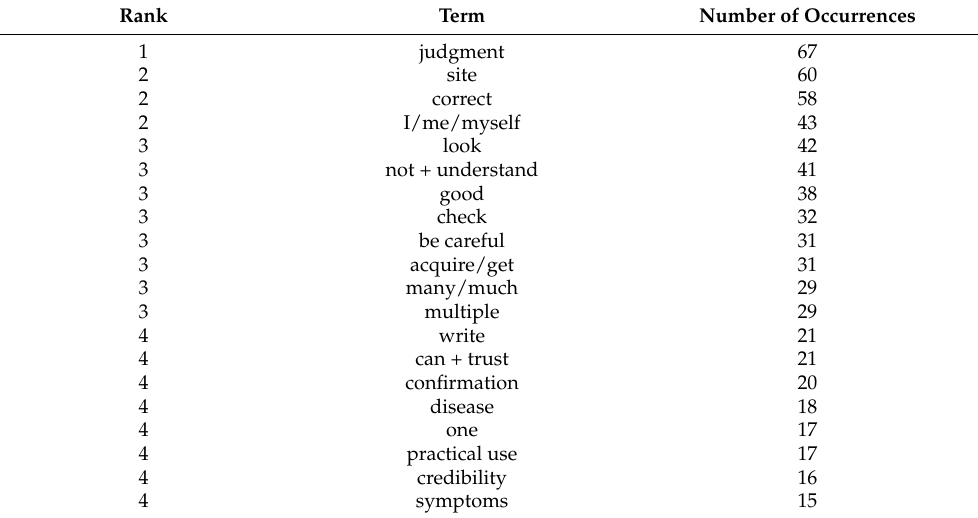
Table 5. Top 20 most frequent terms among the contents of the open-ended responses.